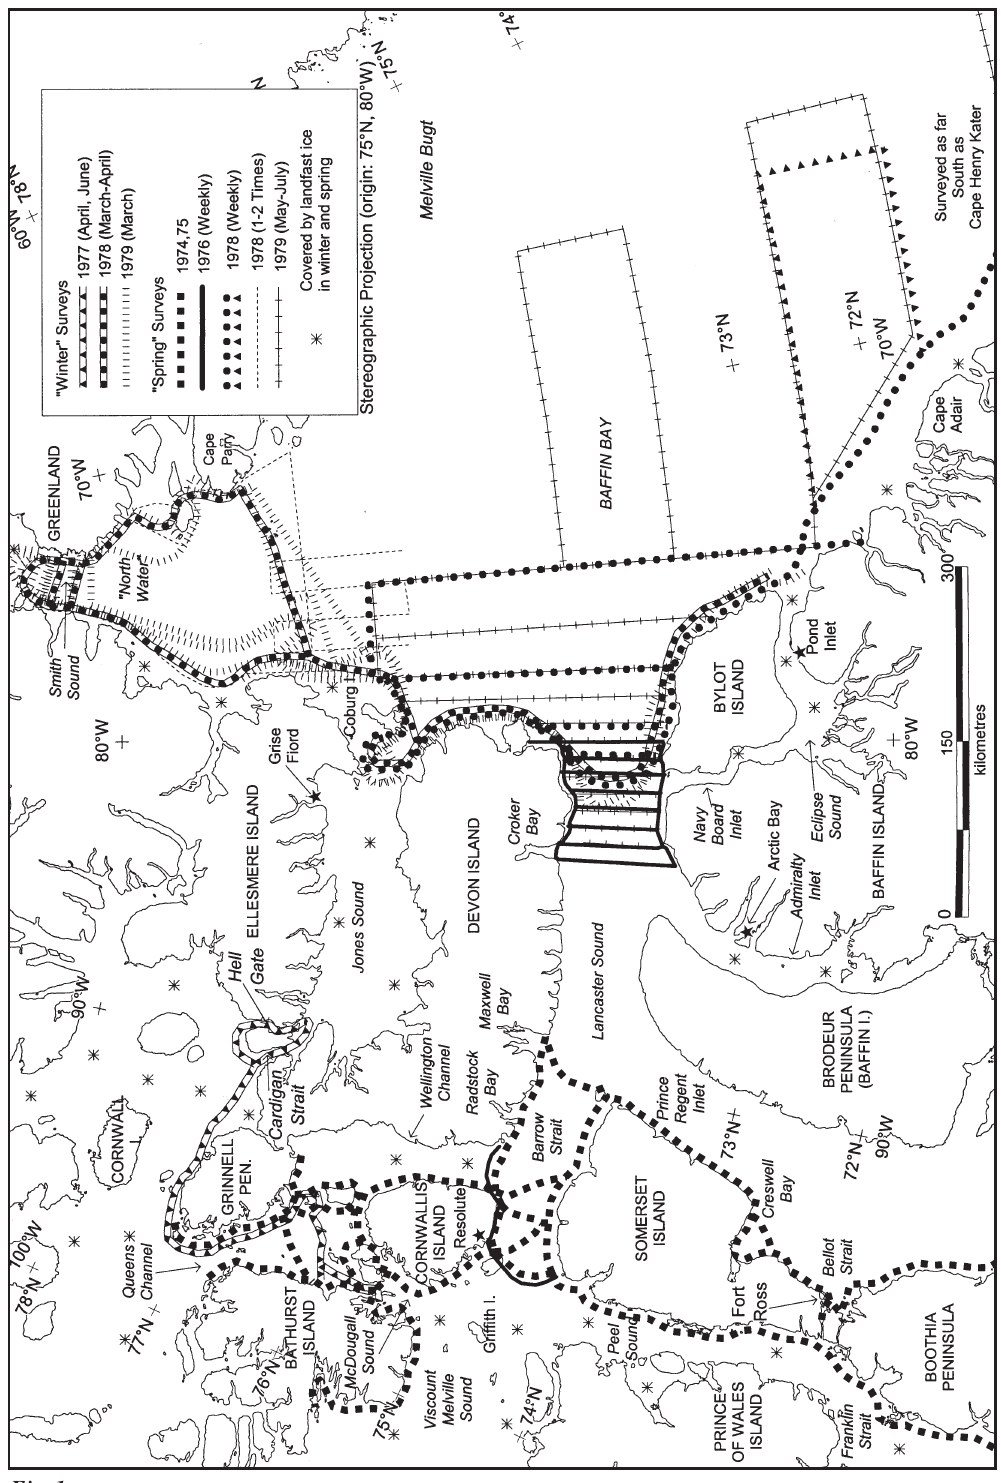
Fig. 1 . Main aerial survey routes during the overwintering and spring migration periods (March-July), 1974-79. Additional surveys of landfast ice in the Barrow Strait, Peel Sound and Viscount Melville Sound areas (west to Melville Island) are not